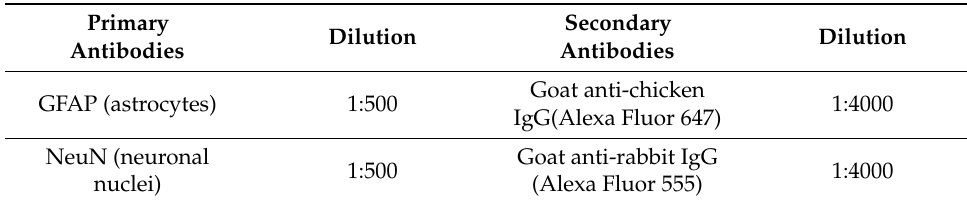
Table 1. Antibody